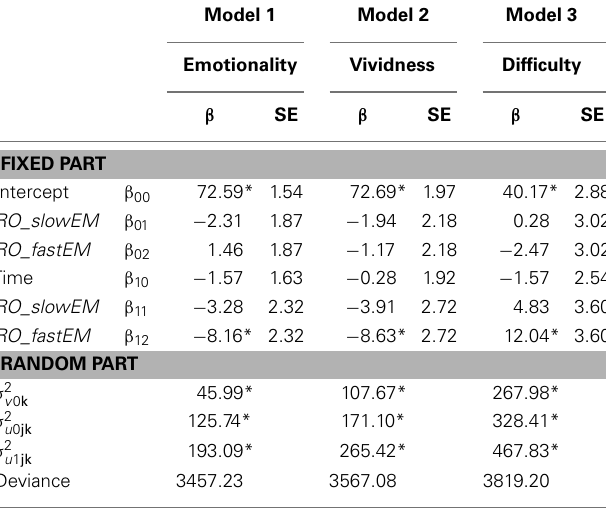
Table 1 | Fixed and random parts of Model 1 (emotionality over time between conditions), Model 2 (vividness over time between conditions), and Model 3 (difficulty over time between conditions)